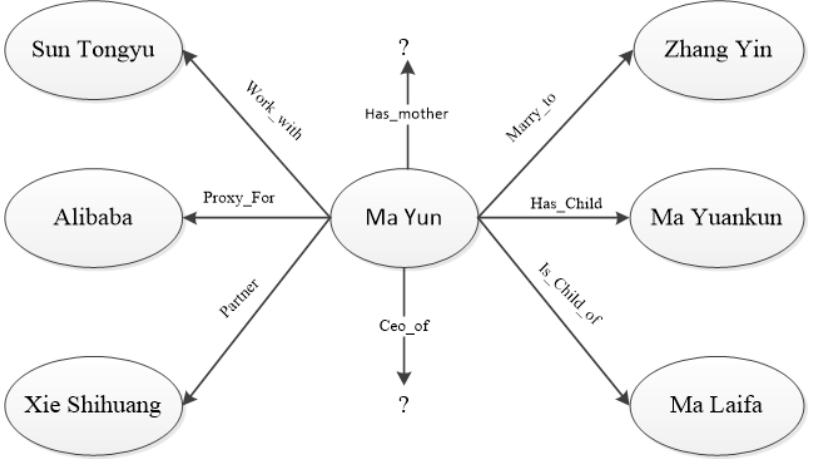
Figure 1. Schematic diagram of knowledge graph reasoning attribute relationship.